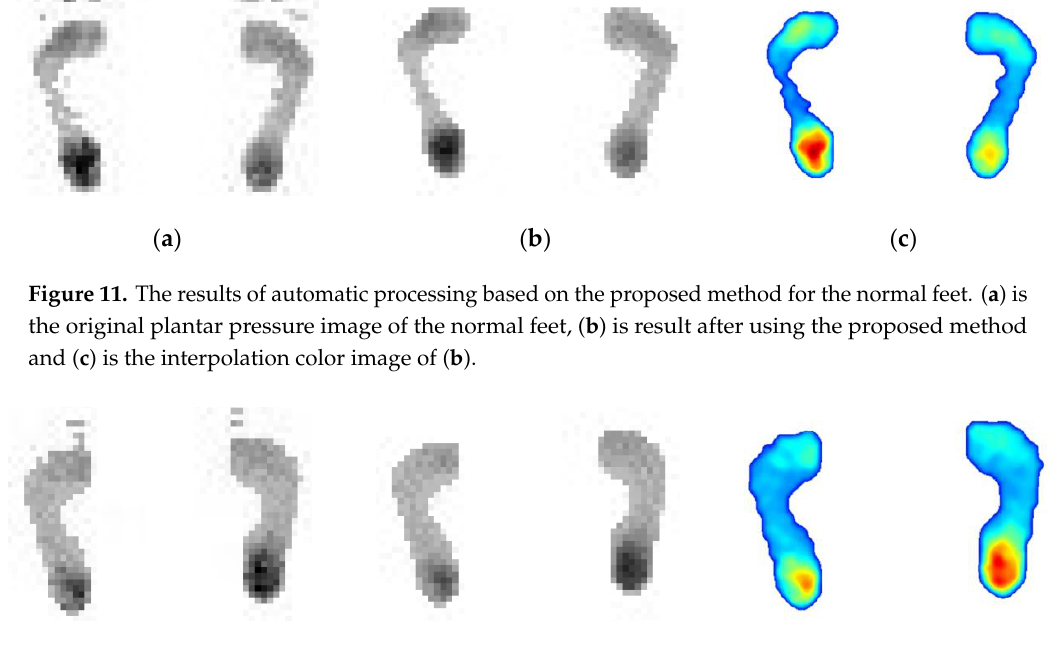
Figure 10. The results of automatic processing based on the proposed method for the high arch feet. ( a ) is the original plantar pressure image of the high arch feet, ( b ) is result after using the proposed method and ( c ) is the interpolation color image of ( b ).